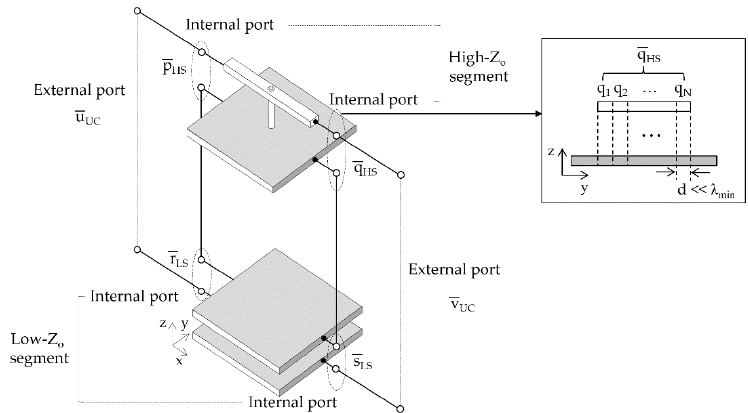
Figure 5. Decomposition of the DGS–EBG unit cell into high- and low-Z o segments.